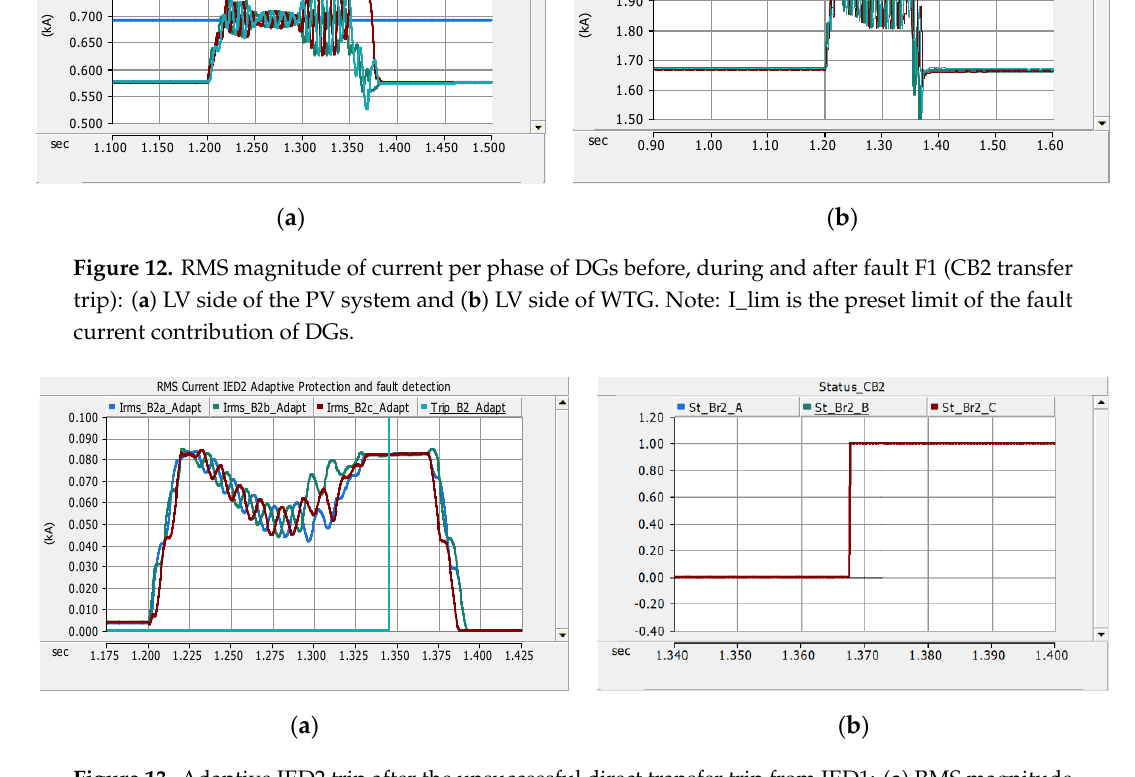
Figure 13. Adaptive IED2 trip after the unsuccessful direct transfer trip from IED1: ( a ) RMS magnitude of the current at adaptive IED2 and relay operating time and ( b ) CB2 status and operating time during an IED2 adaptive trip.